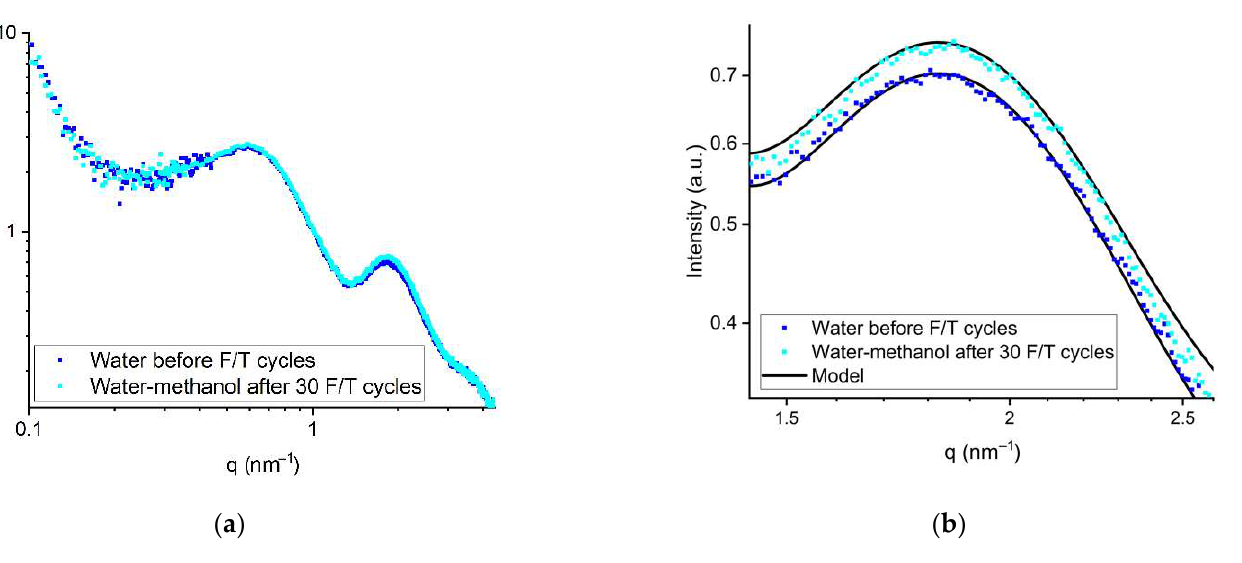
Figure 5. SAXS profiles of the membranes swollen in water and in a water-methanol mixture before and after 30 F/T cycles, respectively (the entire measuring range ( a ) and the region of the ionic domains peak ( b )). Table 4. The size of ionic domains for the Nafion ® 212 membrane swollen in water and a water- methanol mixture.